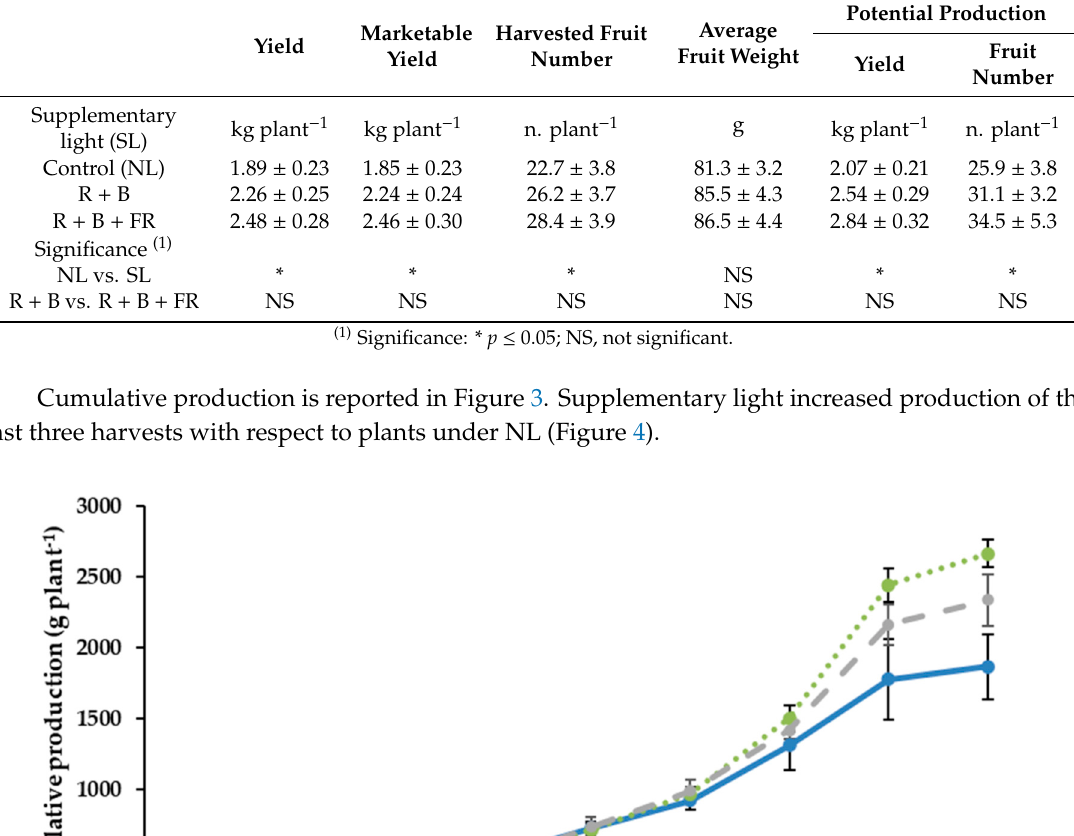
Table 3. E ff ects of di ff erent SL spectra (R + B vs. R + B + FR) and di ff erent light conditions (NL vs. SL) on tomato plant yield, marketable yield, harvested fruit number, average fruit weight, potential yield and potential fruit number. Values are average ± DS of three replications made during the growing cycle.